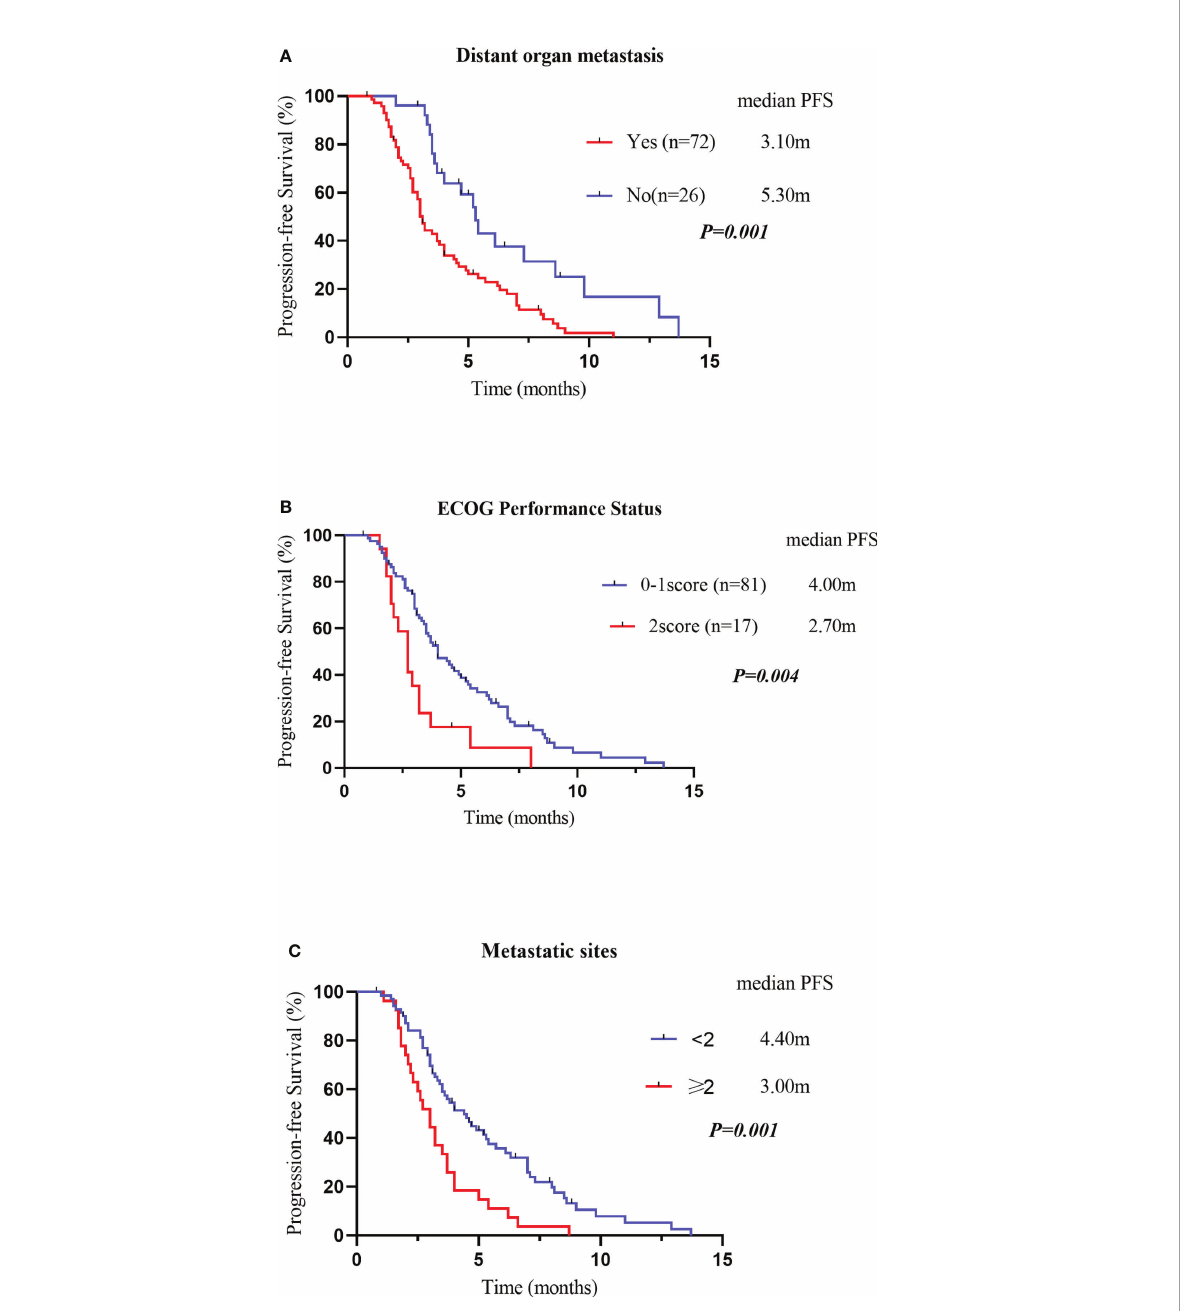
FIGURE 6 Kaplan – Meier survival curves for PFS were compared among patients with or without distant organ metastasis (A) . PFS, Progression-Free Survival Kaplan – Meier survival curves for PFS were compared among patients with different Eastern Cooperative Oncology Group performance statuses (B) . PFS, Progression-Free Survival Kaplan – Meier survival curves for PFS were compared among patients with different metastatic sites (C) . PFS, Progression-Free